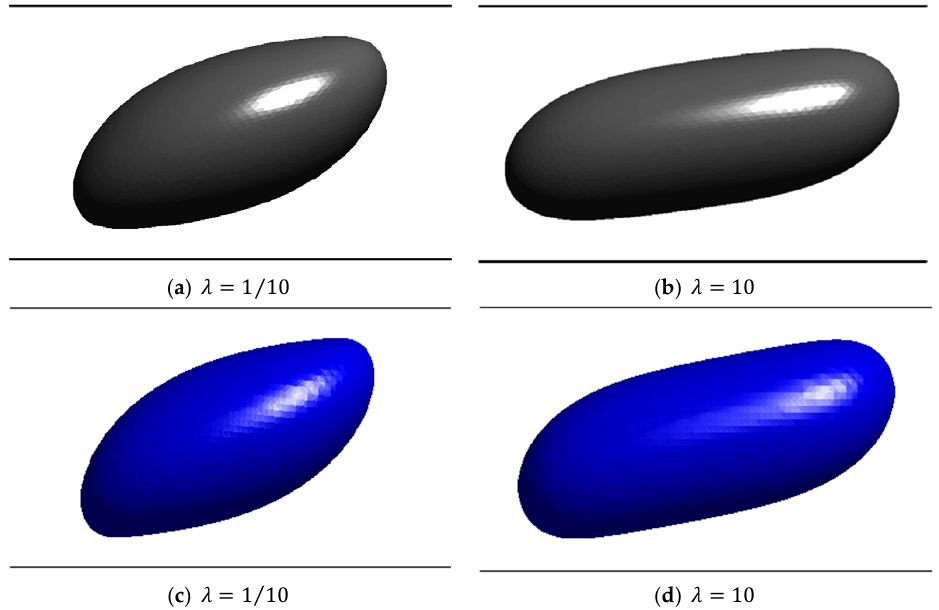
Figure 19. The steady shapes of the drops with the diameter of 2 R drop = 0.9 H and Ca = 0.3 for different values of the viscosity ratios ( λ = 0.1 and 10), ( a , b ): Reported by Janssen and Anderson [35] (Reproduced with permission from Author; published by Elsevier, 2008), ( c , d ): Generated in the present research.